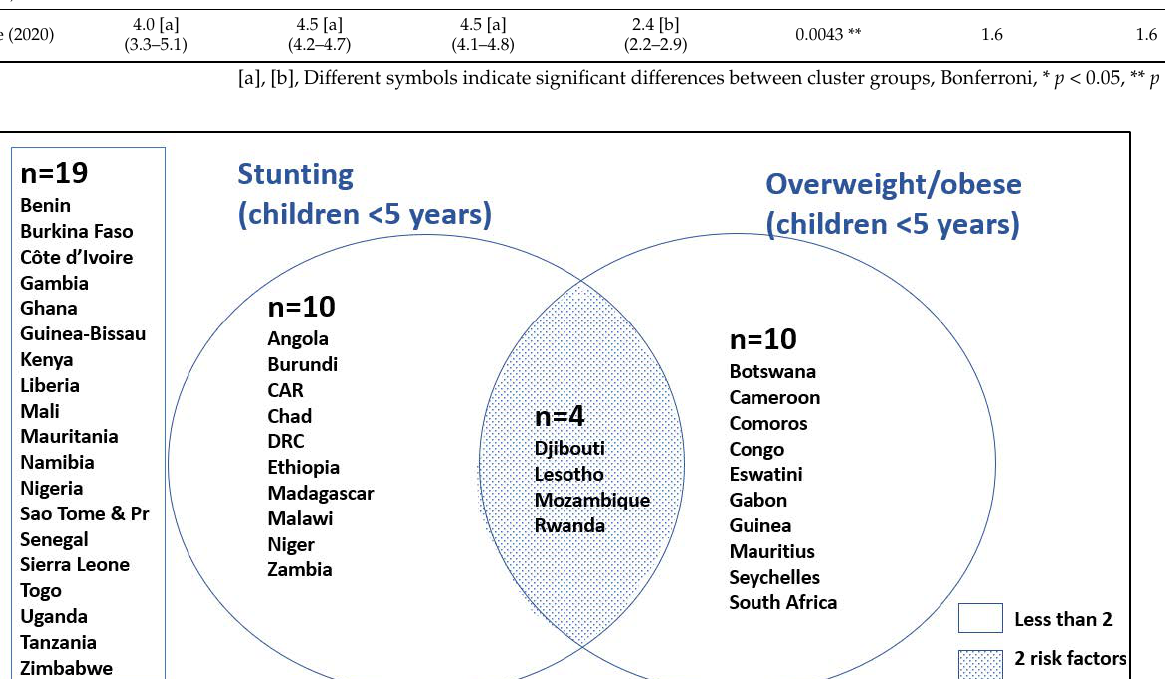
Figure 7. A Venn diagram showing the double burden of malnutrition in SSA countries illustrated by under-five child stunting and women overweight/obese (only those in the top tertile are in the diagram). Figure 8 presents data on countries illustrating evidence of the epidemiological tran- sition. Three countries, Lesotho, Eswatini, and Botswana, show four risk indicators; namely, they lie in the highest tertile for women and children being overweight, women with type 2 diabetes, and individuals with hypertension. Countries with three of the risk factors include Comoros, Gabon, Seychelles, and South Africa.